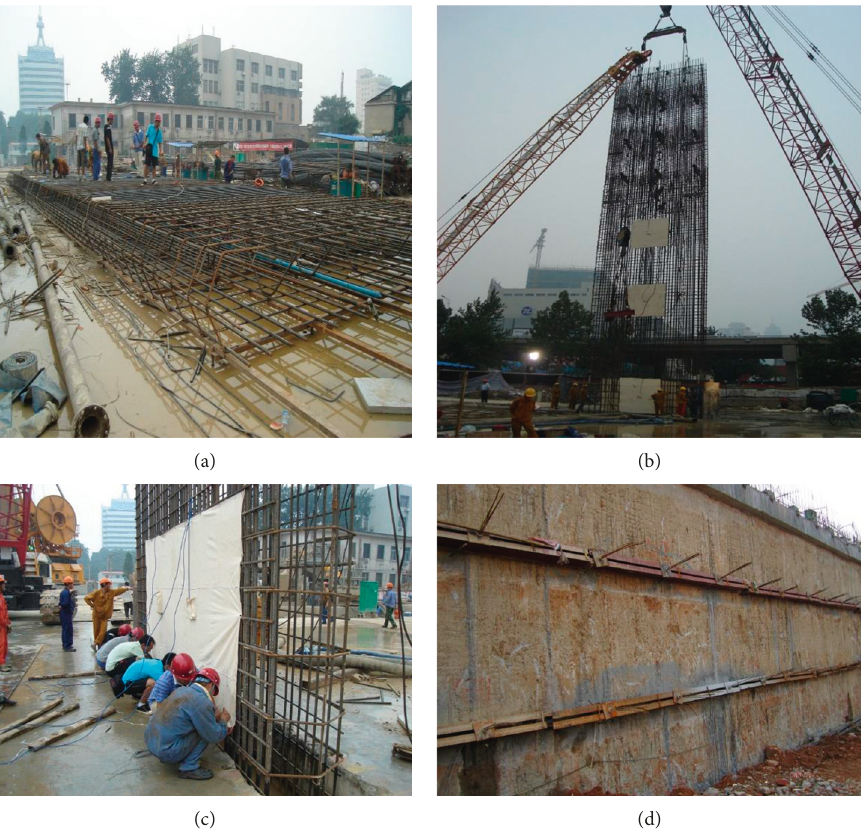
Figure 9: Field monitoring instruments. (a) Inclinometer and strain gauge. (b) Earth pressure cells. (c) Piezometers. (d) Anchor strain